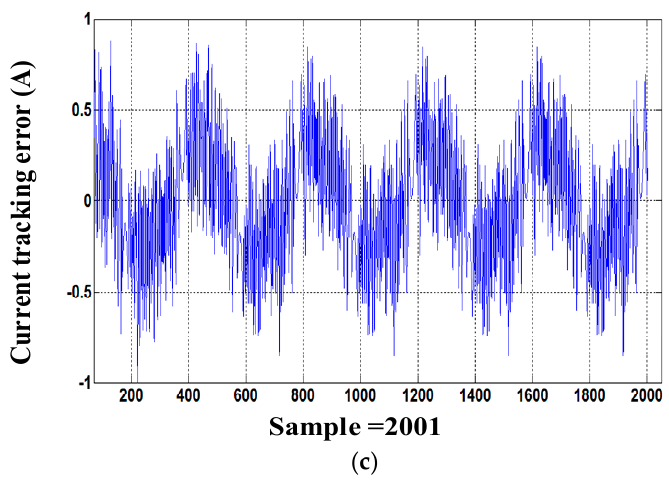
Figure 10. The results of proposed NSV-MPC: ( a ) The percentages of THD with respect to variation in inductive value, ( b ) Reference and measured currents, ( c ) Current tracking error of phase x .